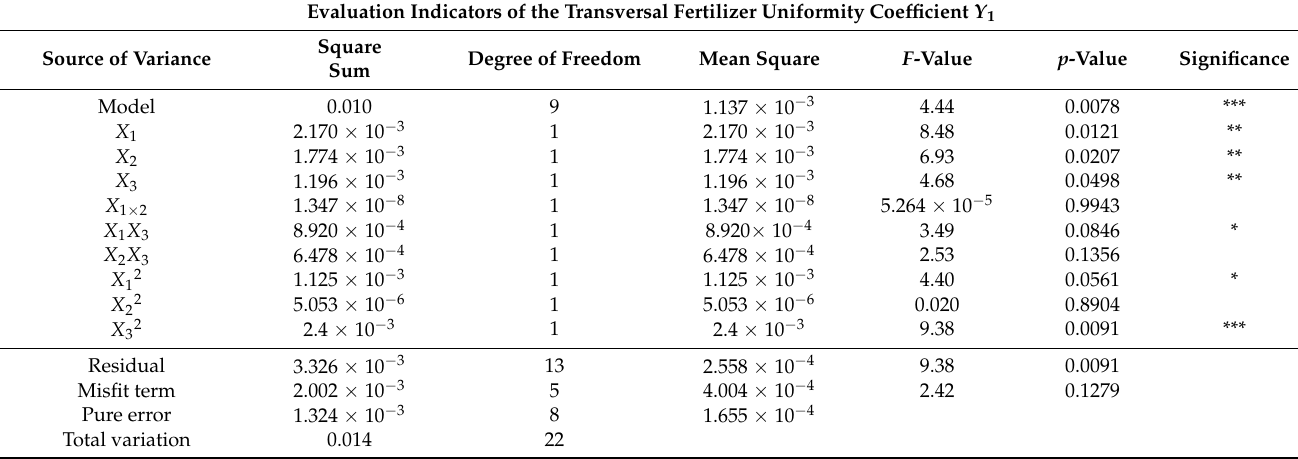
Table 5. Analysis of variance for lateral uniformity